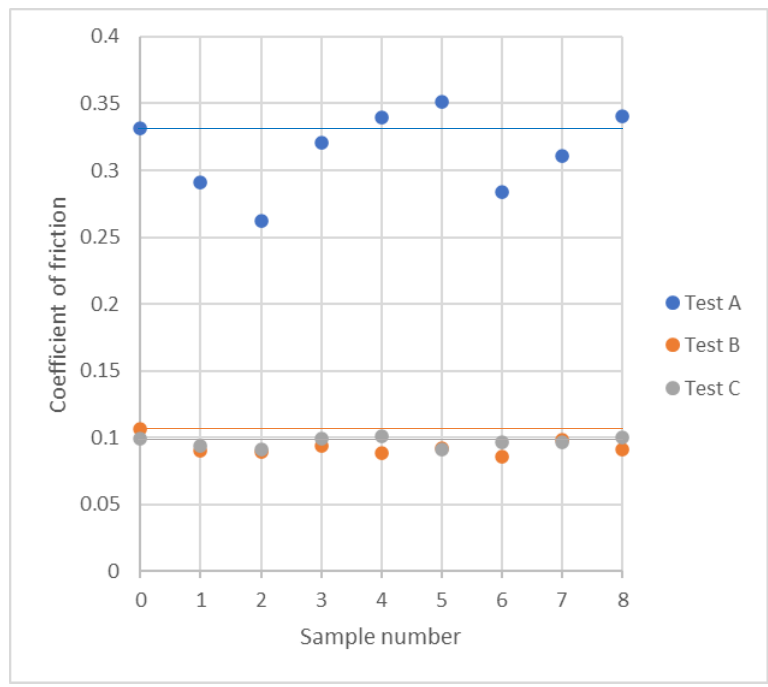
Figure 6. Average COF values obtained under different test conditions.